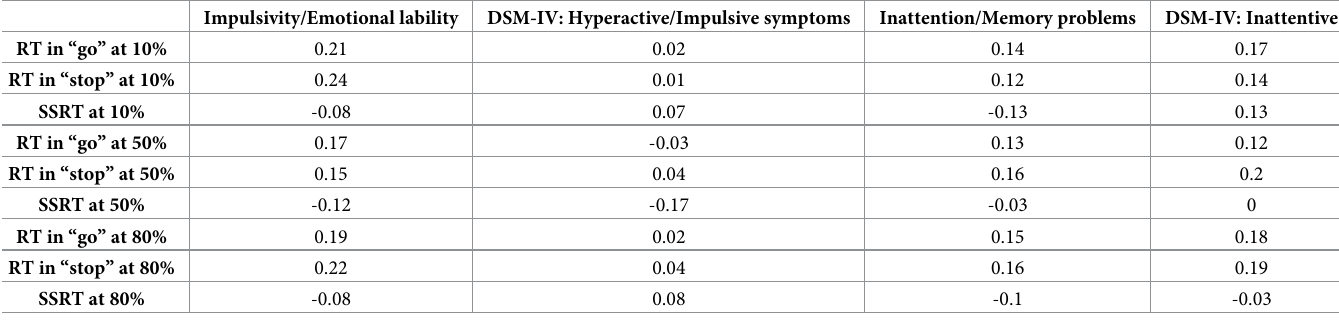
Table 12. Values of Spearman’s ρ for correlations between keypress measures and impulsivity/inattention measures at different coherence levels. Impulsivity/Emotional